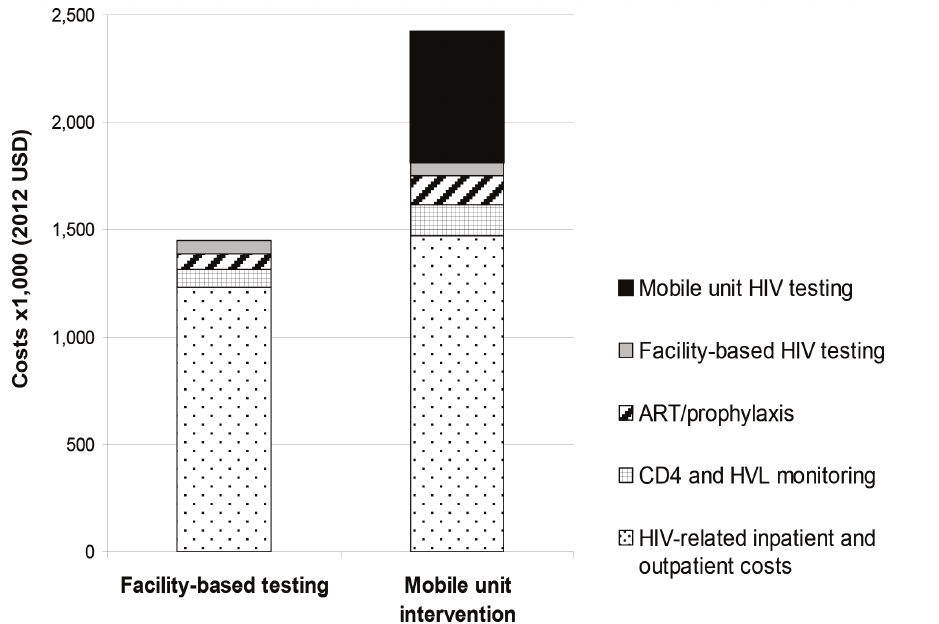
Figure 4. Total HIV-related cohort costs over initial 2 years in facility-based and mobile intervention strategies. This represents the total undiscounted costs for the cohort of 18,870 for HIV-related costs over the first 2 years, to be incurred by the Western Cape Department of Health. For both strategies HIV-related costs are comprised of HIV screening, routine CD4 and HIV RNA monitoring, ART and prophylaxis, and HIV- related inpatient and outpatient costs. Costs are 6 1,000 USD. HIV: human immunodeficiency virus, ART: antiretroviral